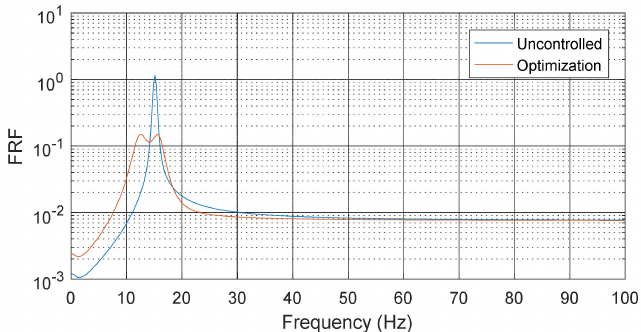
Figure 8. Frequency response function (FRF) of electrical cabinet before and after optimization under sinusoidal sweep wave.